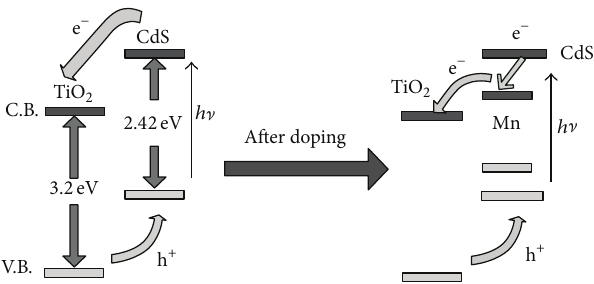
Figure 4: The TiO 2 /CdS energy level structure diagram before and after doping.